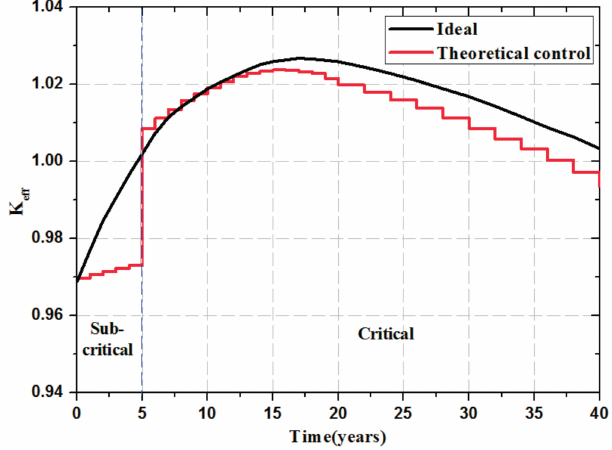
Figure 5. Time-dependent distribution of the ideal and theoretical control K eff in subcritical and critical alternative